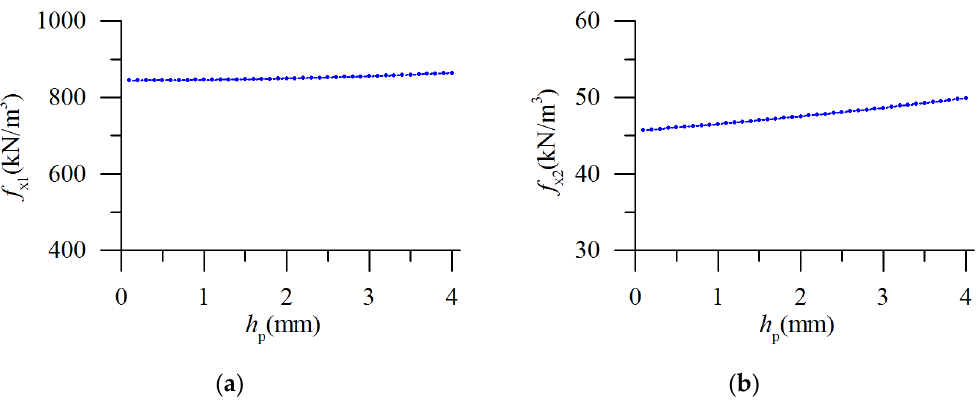
Figure 8. The curves of the two ‐ eddy current braking force density along with the change of h p . ( a ) The curve of f x1 along with the change of h p ; ( b ) The curve of f x2 along with the change of h p . From Equation (15), it can be observed that the volatile component of the eddy current brake force associated with the value of L p / τ . It can be observed from Figure 9a, f x1 remains relatively